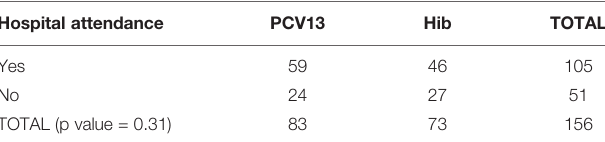
TABLE 5 | Hospital attendance for AEs per study arm.